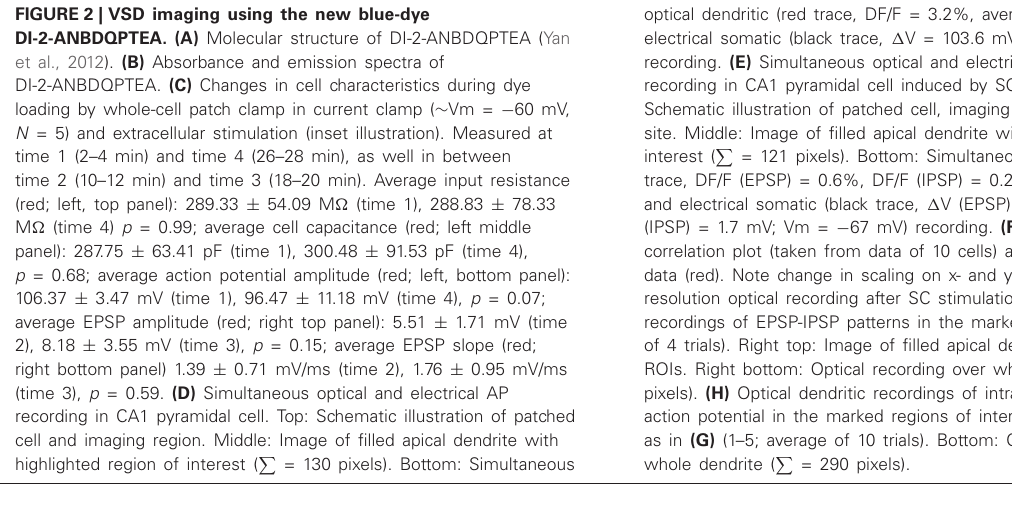
FIGURE 2 | VSD imaging using the new blue-dye DI-2-ANBDQPTEA. (A) Molecular structure of DI-2-ANBDQPTEA (Yan et al., 2012). (B) Absorbance and emission spectra of DI-2-ANBDQPTEA. (C) Changes in cell characteristics during dye loading by whole-cell patch clamp in current clamp ( ∼ Vm = − 60 mV, N = 5) and extracellular stimulation (inset illustration). Measured at time 1 (2–4 min) and time 4 (26–28 min), as well in between time 2 (10–12 min) and time 3 (18–20 min). Average input resistance (red; left, top panel): 289.33 ± 54.09 M Ω (time 1), 288.83 ± 78.33 M Ω (time 4) p = 0.99; average cell capacitance (red; left middle panel): 287.75 ± 63.41 pF (time 1), 300.48 ± 91.53 pF (time 4), p = 0.68; average action potential amplitude (red; left, bottom panel): 106.37 ± 3.47 mV (time 1), 96.47 ± 11.18 mV (time 4), p = 0.07; average EPSP amplitude (red; right top panel): 5.51 ± 1.71 mV (time 2), 8.18 ± 3.55 mV (time 3), p = 0.15; average EPSP slope (red; right bottom panel) 1.39 ± 0.71 mV/ms (time 2), 1.76 ± 0.95 mV/ms (time 3), p = 0.59. (D) Simultaneous optical and electrical AP recording in CA1 pyramidal cell. Top: Schematic illustration of patched cell and imaging region. Middle: Image of filled apical dendrite with highlighted region of interest ( (cid:80) = 130 pixels). Bottom: Simultaneous